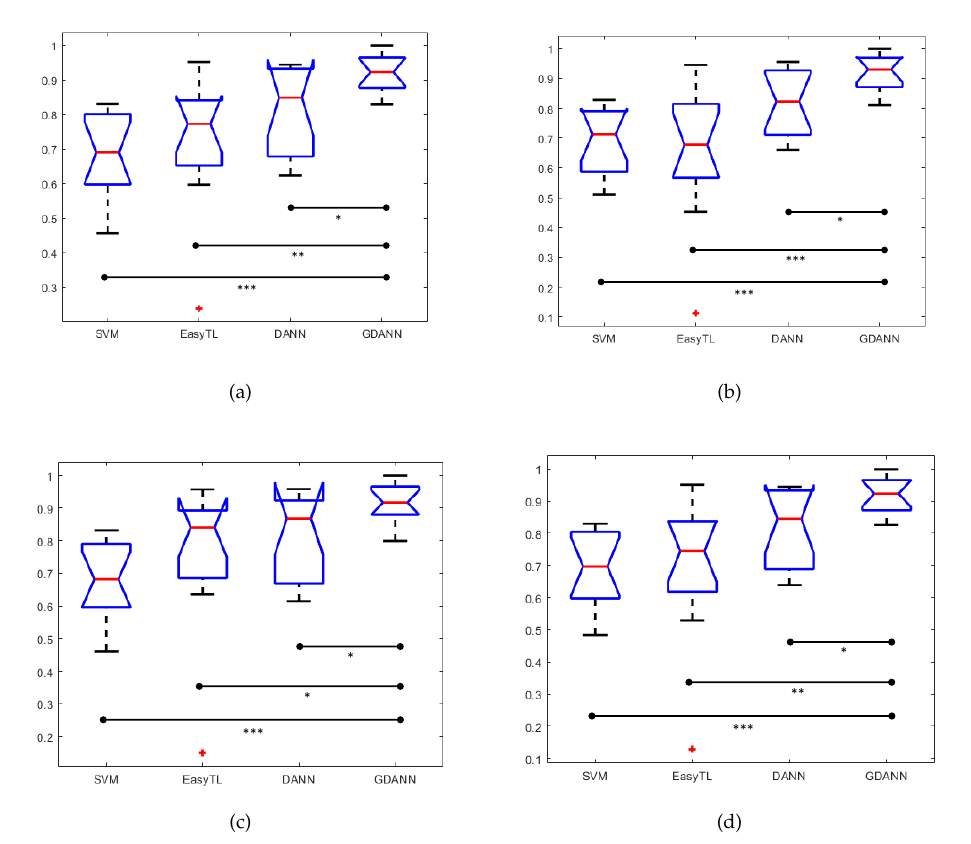
Figure 11. Box plots of confusion matrix (( a ) Accuracy, ( b ) Precision, ( c ) Recall, and ( d ) F1Score) between SVM, EasyTL, DANN and GDANN. ( ∗ indicates p < 0.05; ∗∗ indicates p < 0.01; ∗∗∗ indicates p <